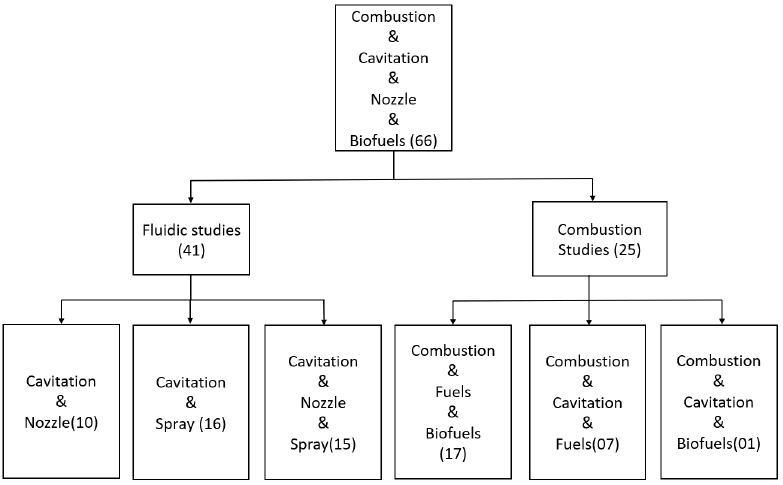
Figure 5. Bibliographic research diagram.